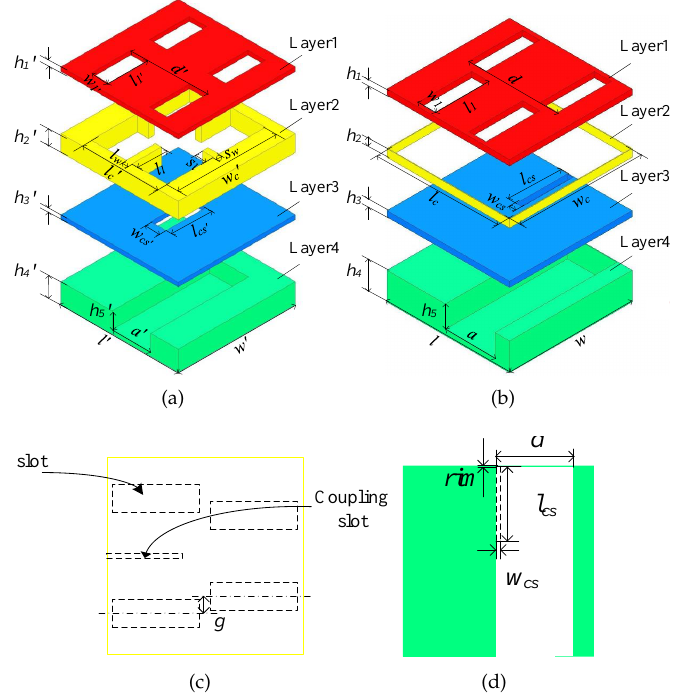
Figure 2. Configuration of ( a ) the primary and ( b ) the improved 2 × 2-slot subarrays, and the top views to show the detailed dimension relationship of the improved subarray ( c ) among “Layer1”, “Layer2”, and “Layer3” and ( d ) between “Layer3” and “Layer4”. According to the exploded perspective view of the primary 2 × 2-element